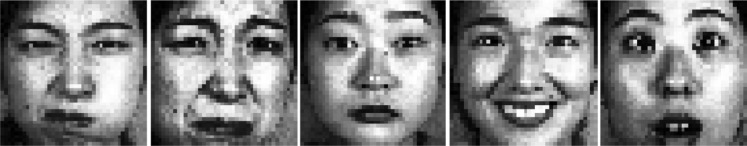
JAFFE images after pre-processing.